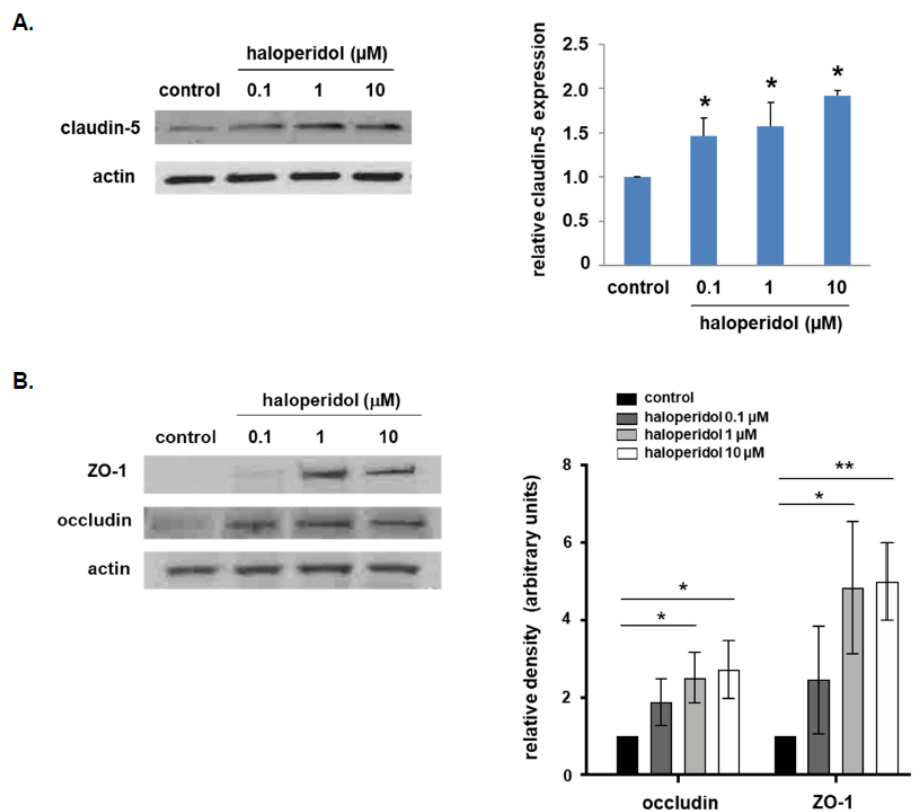
Figure 1. Claudin-5, ZO-1, and occludin expression is increased in lung ECs after haloperidol treatment. Human pulmonary artery ECs were treated with haloperidol (0.1, 1.0, or 10 µ M) for 24 h and whole cell lysates were then collected and subjected to Western blotting for ( A ) claudin-5 or ( B ) ZO-1 or occludin with untreated cells used as controls. Expression of all three tight junctional proteins was significantly increased in response to haloperidol with an appreciable dose-dependent response ( n = 3, * p < 0.05 and ** p < 0.01 compared to respective untreated controls; representative blots shown).